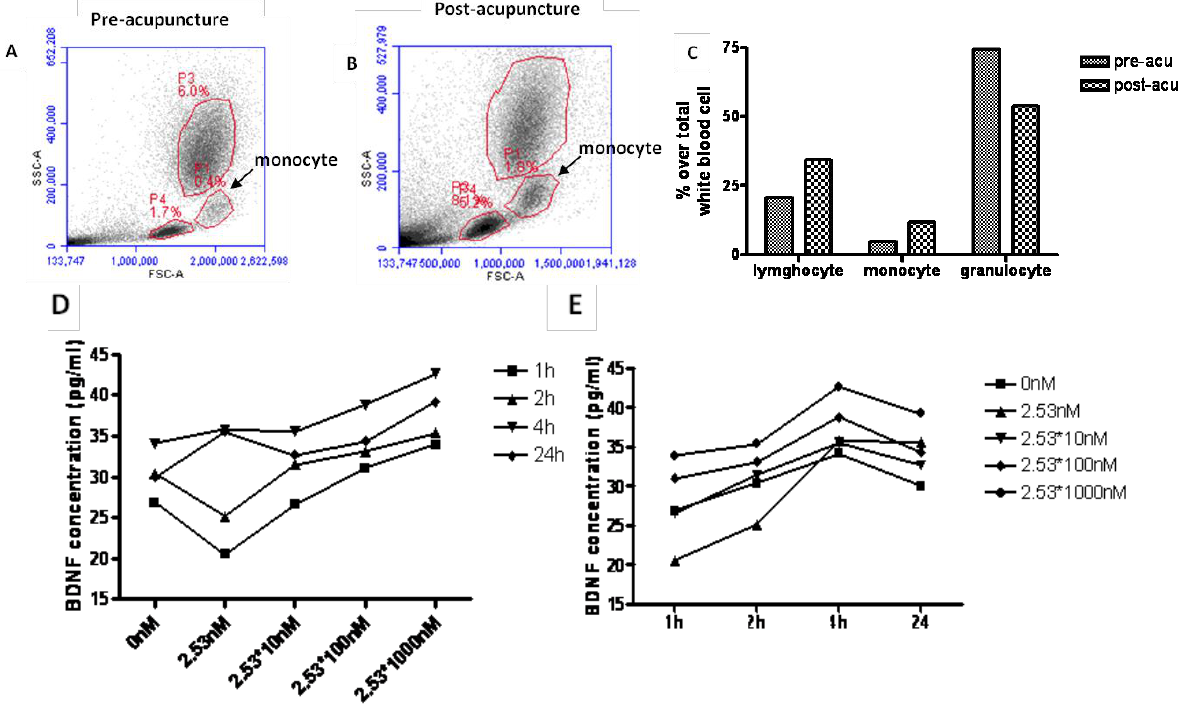
Figure 2. The relationship between monocytes and BDNF expression in acupuncture. ( A ) cell distribution before acupuncture; ( B ) cell distribution post acupuncture; ( C ) is the graph of data from A and B ; ( D ) BDNF expression after stimulation with ATP at different concentration and ( E ) is the time course expression of BDNF level in J775 cell line stimulated with ATP; The proportion of monocyte was detected by flow cytometry before/after acupuncture. Cluster analysis of monocytes using Forward/Side scatter characteristics. The proportion of monocyte increased from 4.8%–11.8% in PBMC. The granulocyte decreased from 74.4%–53.7%. ( D , E ) The J774 Cell line was treated by ATP from the concentration of 2.53 nM–2.53 µM. After incubated for 24 h, the supernatant was detected by BDNF ELISA kit at 1, 2, 4, and 24 h. The result showed that ATP can induce the expression of BDNF with a dose-dependent, and reach a peak level at 4 h, and then decreased at 24